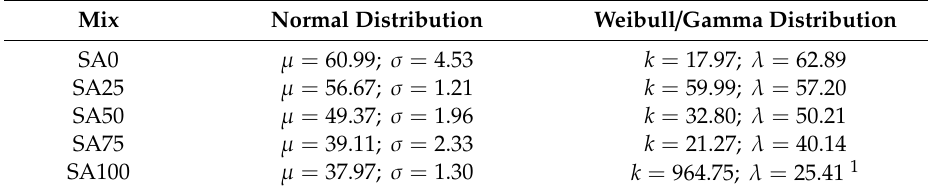
Table 15. Adjustment parameters for the probability distributions of the 28-day compressive strength. Mix Normal Distribution